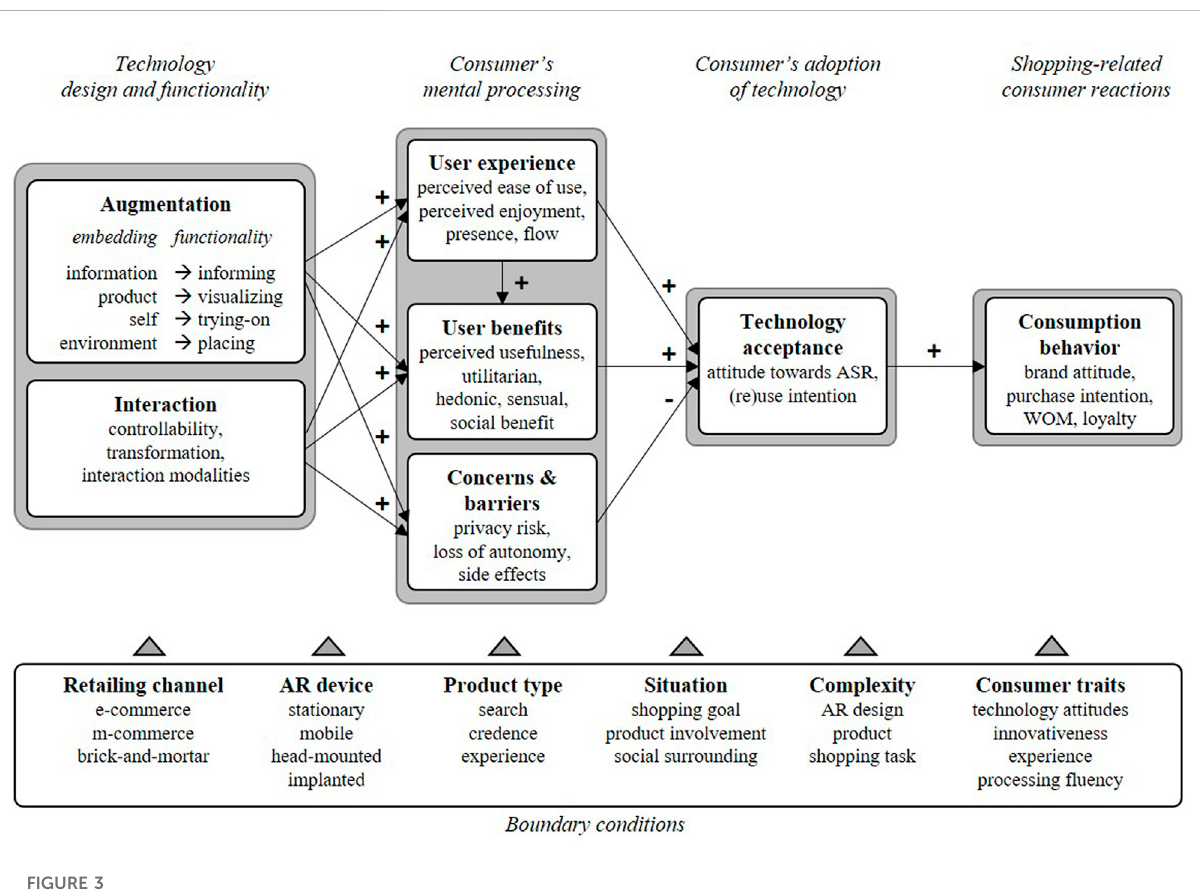
FIGURE 3 Framework model of consumer behavior in augmented shopping